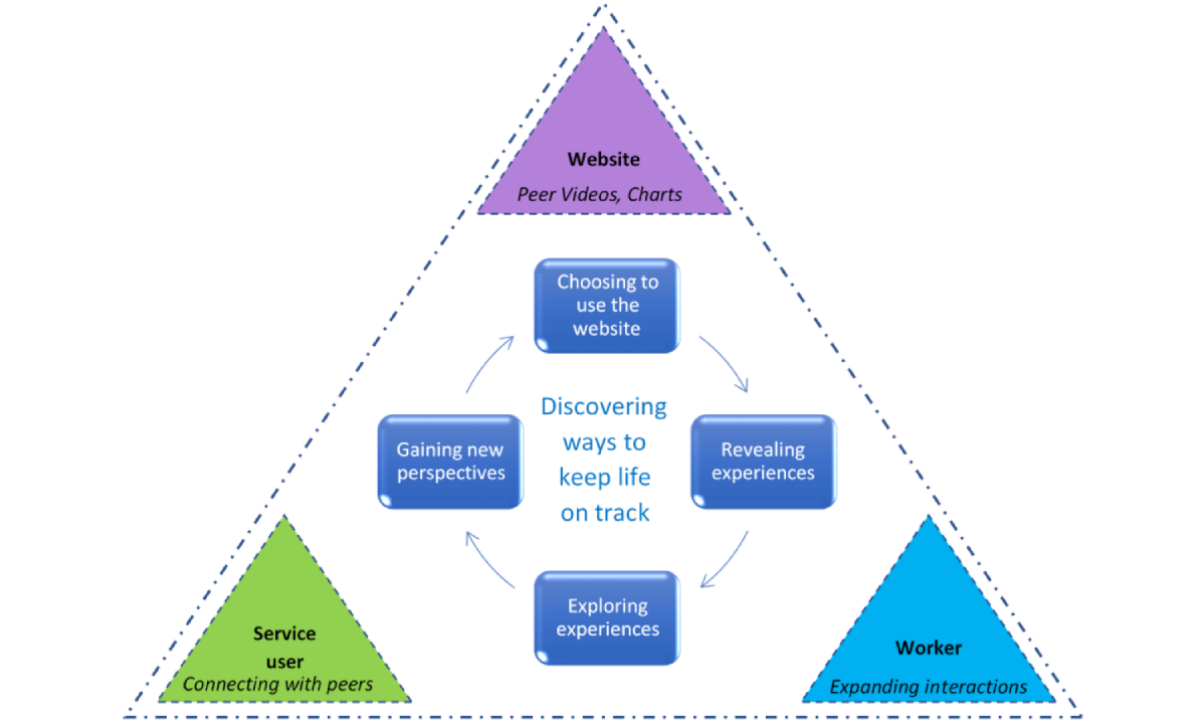
Figure 1. Summary of the process of discovering ways to keep life on